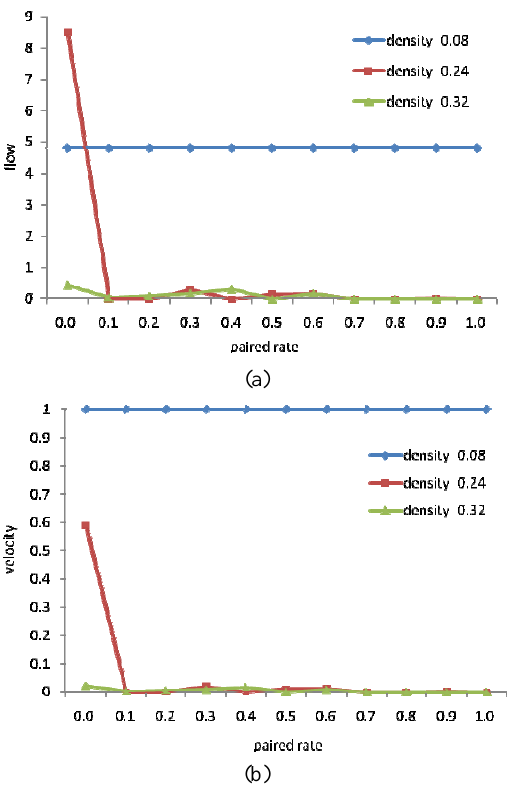
Fig. 5. The flow rate <f> and velocity <v> against paired rates with various densities.